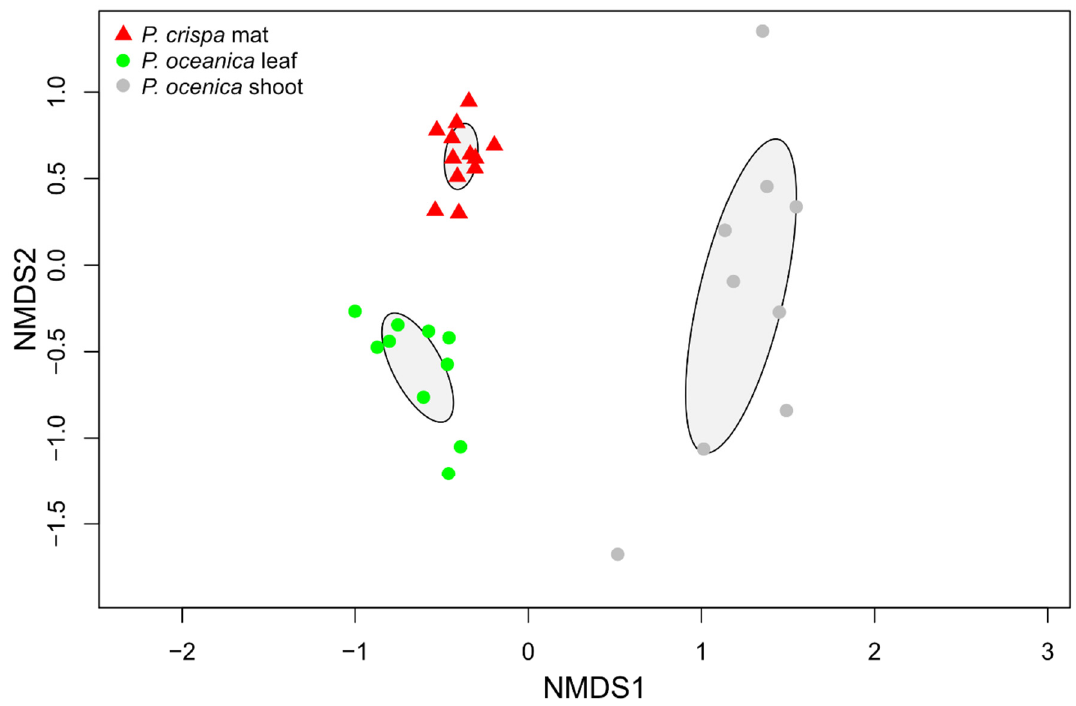
Figure 6. Non-metric multidimensional scaling (NMDS) plot comparing the bryozoan communities found on the three (sub-) habitats across the northern sites (Site Mix, site PC1, site PC2) during the second sampling season (2019).